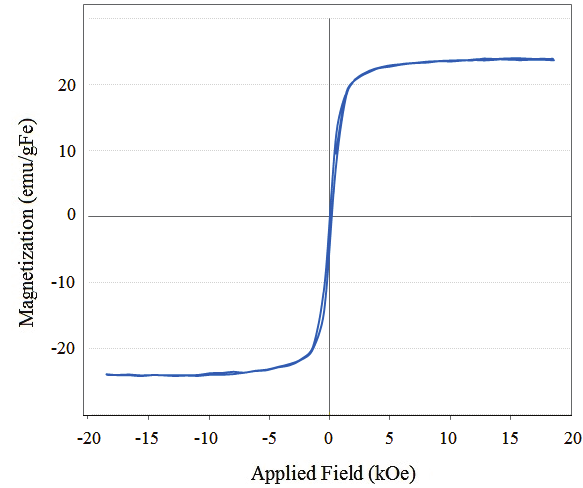
Figure 8: Effect of 1.0 mg/mL of DOX and DOX@ZA (3A, 4A, 5A &M 4 4A) on the SKBr3 cell viability.